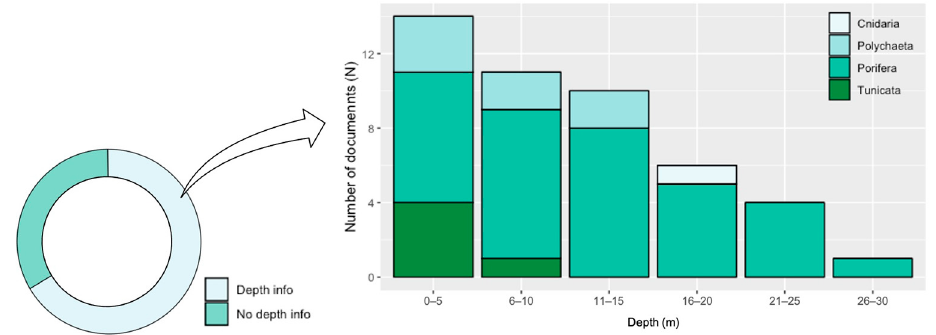
Figure 7. Donut chart of the percentage of documents giving information of the sampled depth(s) ( left ), and number of documents per taxa per depth range ( right ).